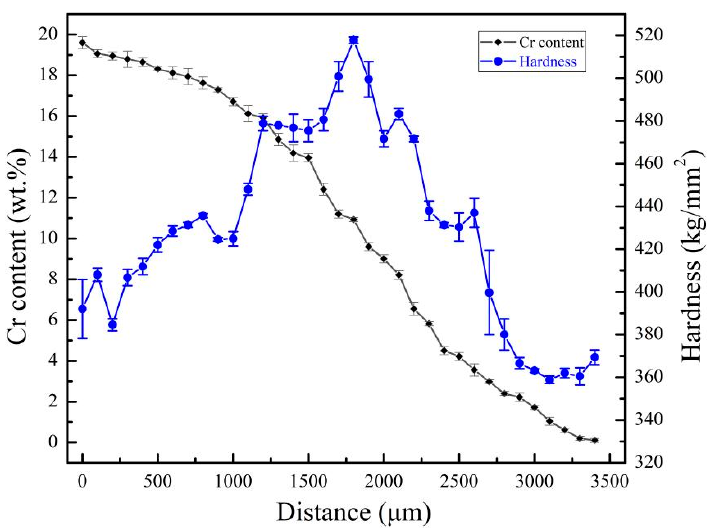
Figure 4. Cr content–hardness relationship of the series Ti ‐ 6Al ‐ xCr alloys, after aging at 600 °C. The variation of the phase fractions of the α and β p hases of the Ti ‐ 6Al ‐ xCr alloys, aged at 600 °C, with Cr content, is shown in Figure 5. Note that in this figure, the laves phase is ignored. The calculated results showed that, with increase in Cr content, the α phase decreased while the β phase increased, which was consistent with the experimental statistical results.